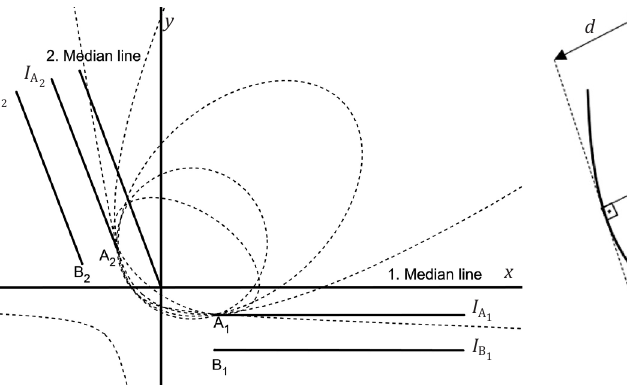
Figure 8. The conic curves connecting A curve (by G. Tinaztepe)